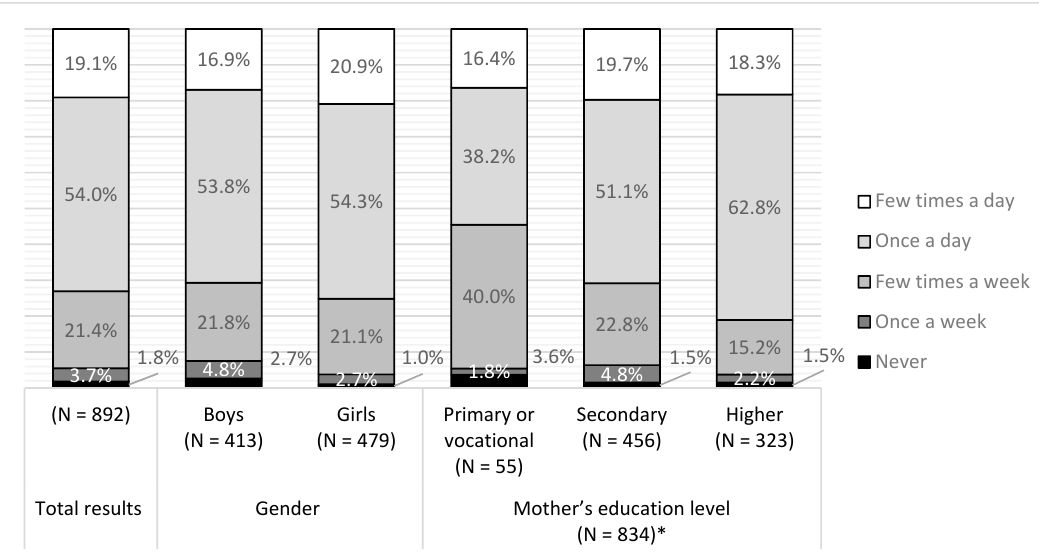
Figure 3. Frequency of fruit consumption in the total surveyed population and sub-groups according to gender and mother’s education level. * 58 mothers did not declare education level.